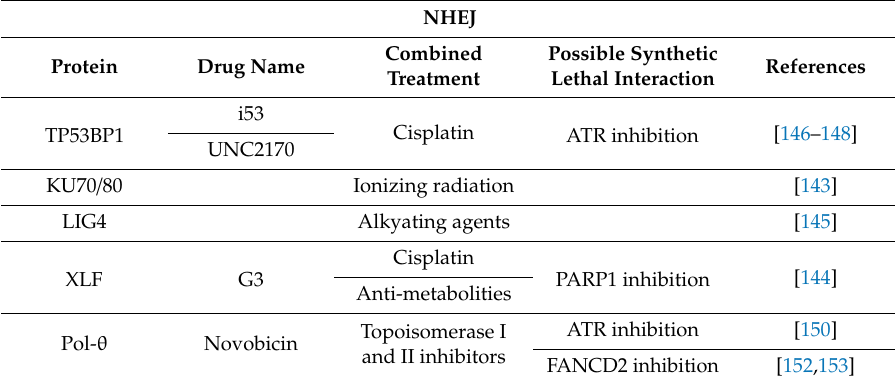
Table 3. NHEJ repair proteins targeted in cancer